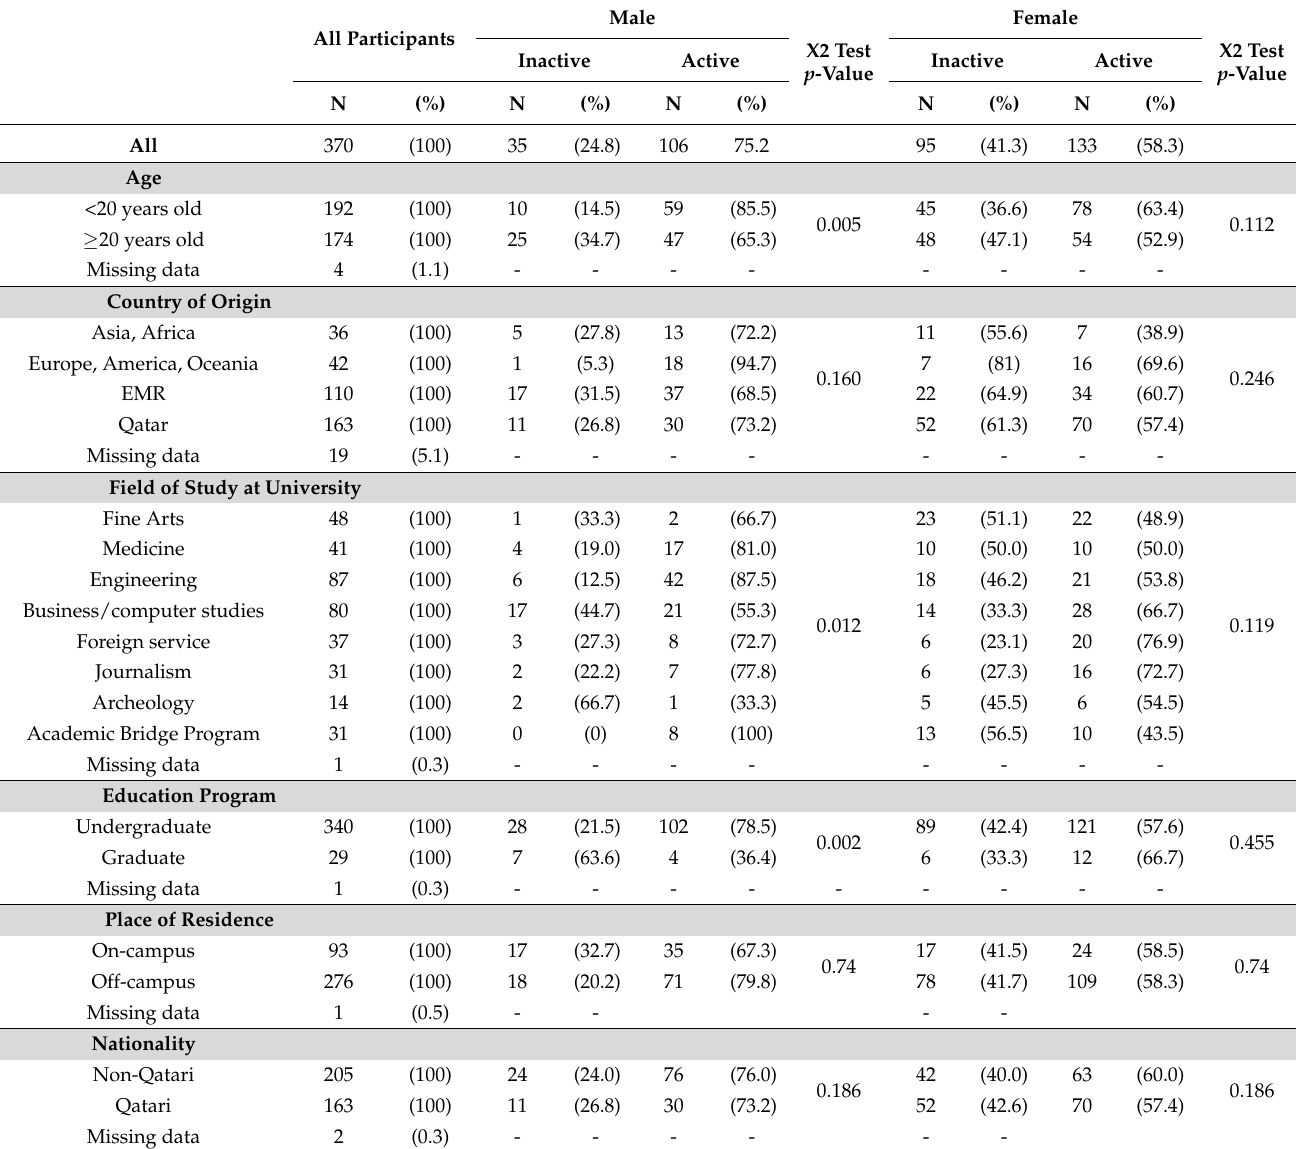
Table 1. Participant characteristics according to their physical activity